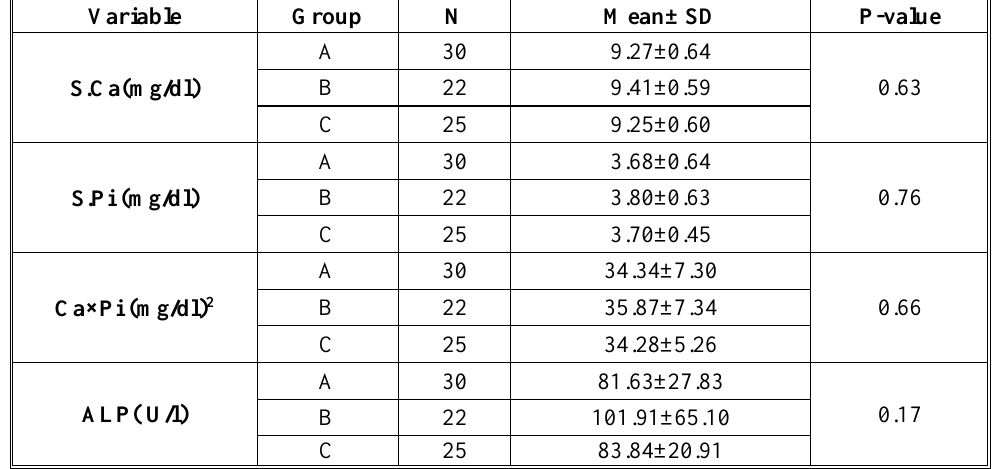
Table3. Descriptive statistics of serum calcium, phosphorus, (calcium*phosphate) product and alkaline phosphatase among groups.